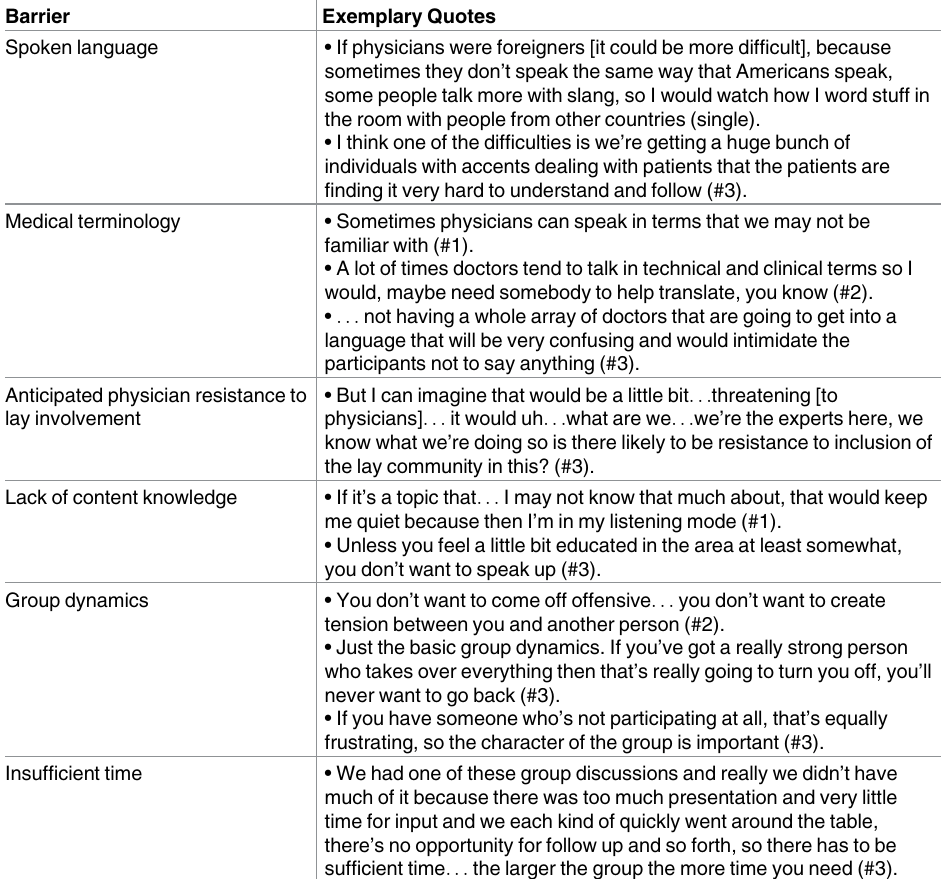
Table 2. Perceived barriersto successful patient participation on guideline development